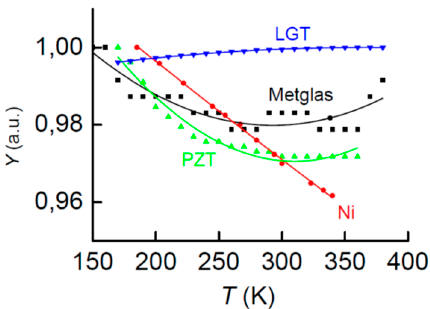
Figure 2. Temperature dependences of the normalized Young’s modulus Y of PE and FM layers. Solid lines represent the approximation of data by a second-order polynomial.